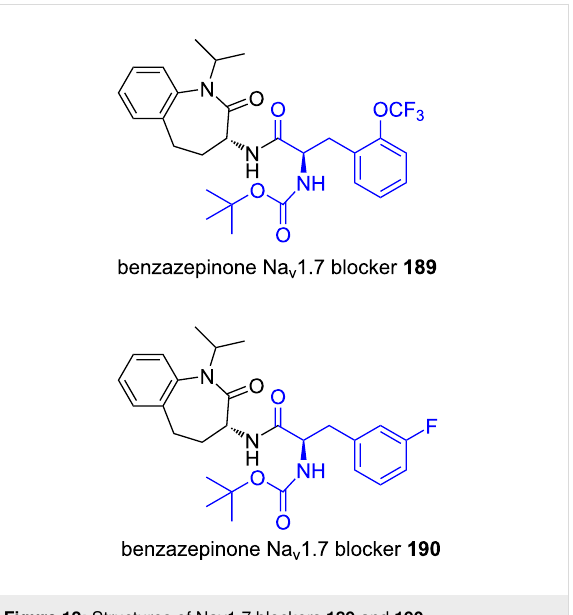
Figure 12: Structures of Nav1.7 blockers 189 and 190